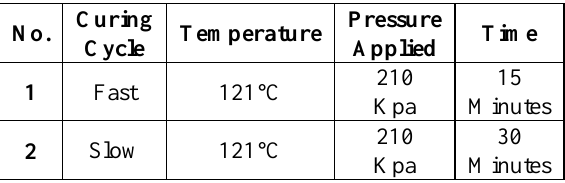
Table 1: showing the curing cycles for the